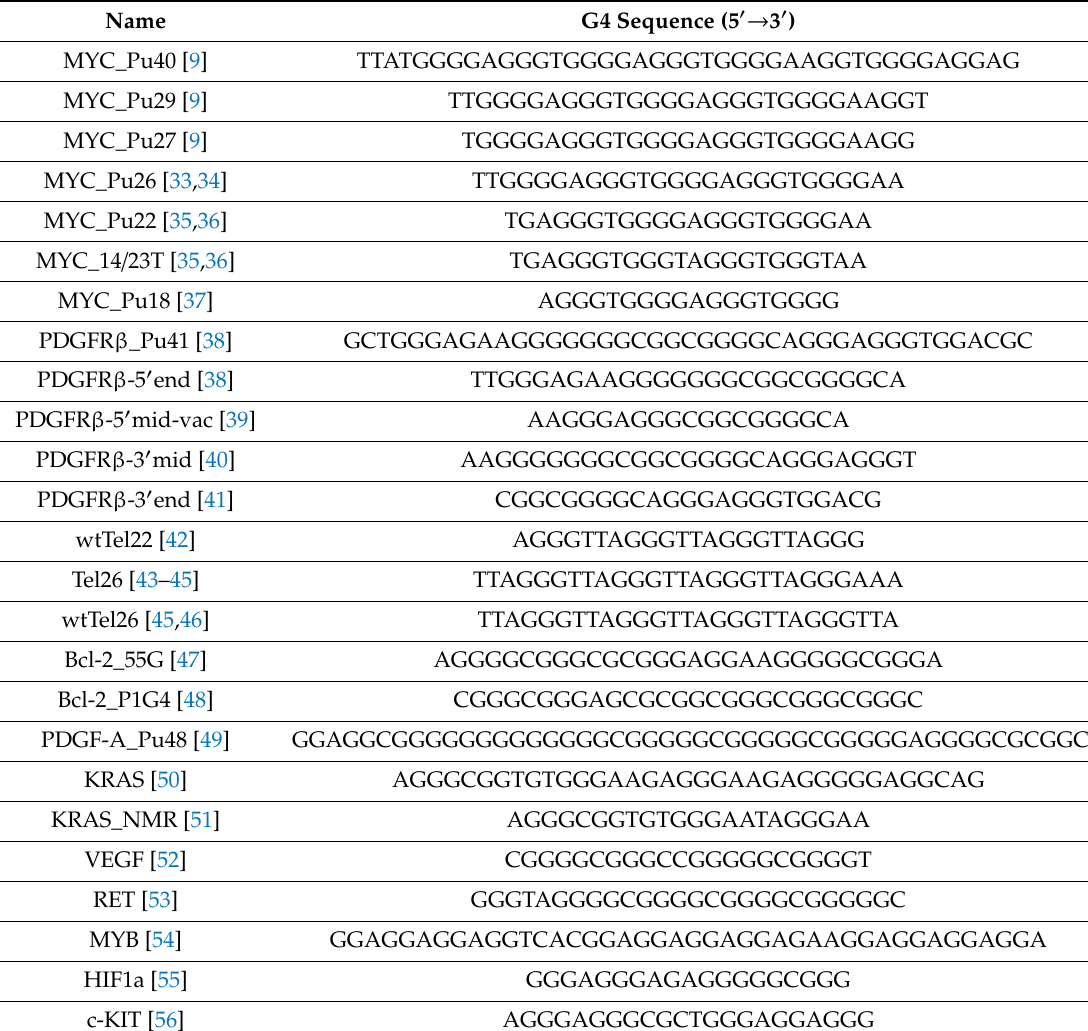
Table 1. G4 sequences analyzed in Figure